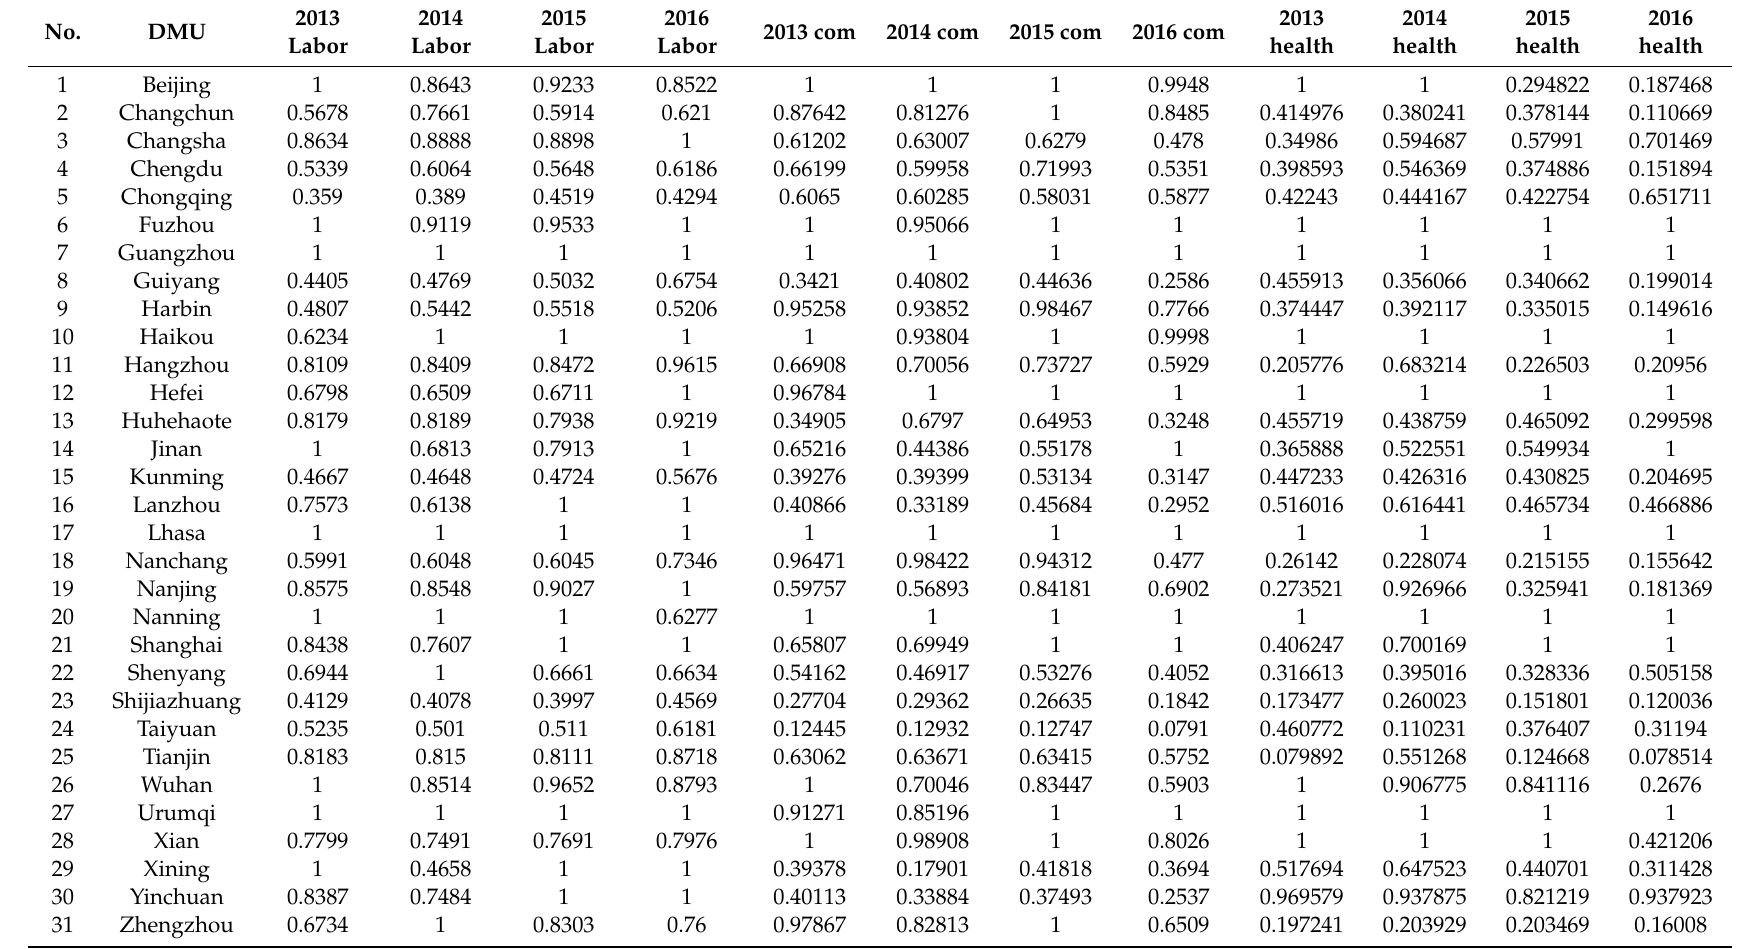
Table 5. Labor, Energy consumption and Health expenditure e ffi